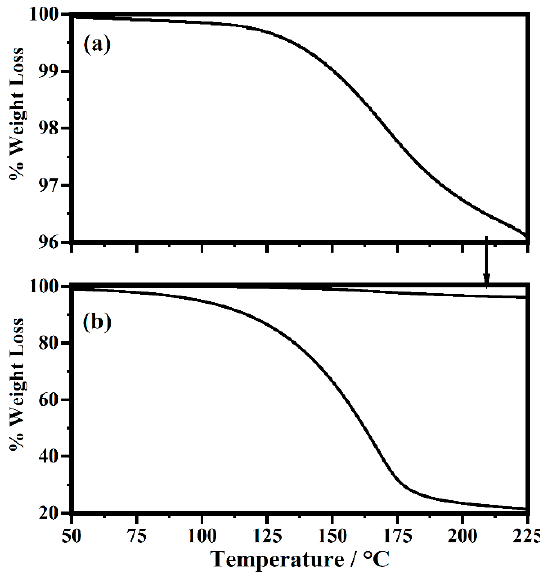
Figure 20. TGA data for PMMA polymer ( a ) and PMMA-Li (0.5 M)-PC-EC gel ( b ). The PMMA data have been plotted in the bottom image for comparison as indicated by the arrow.